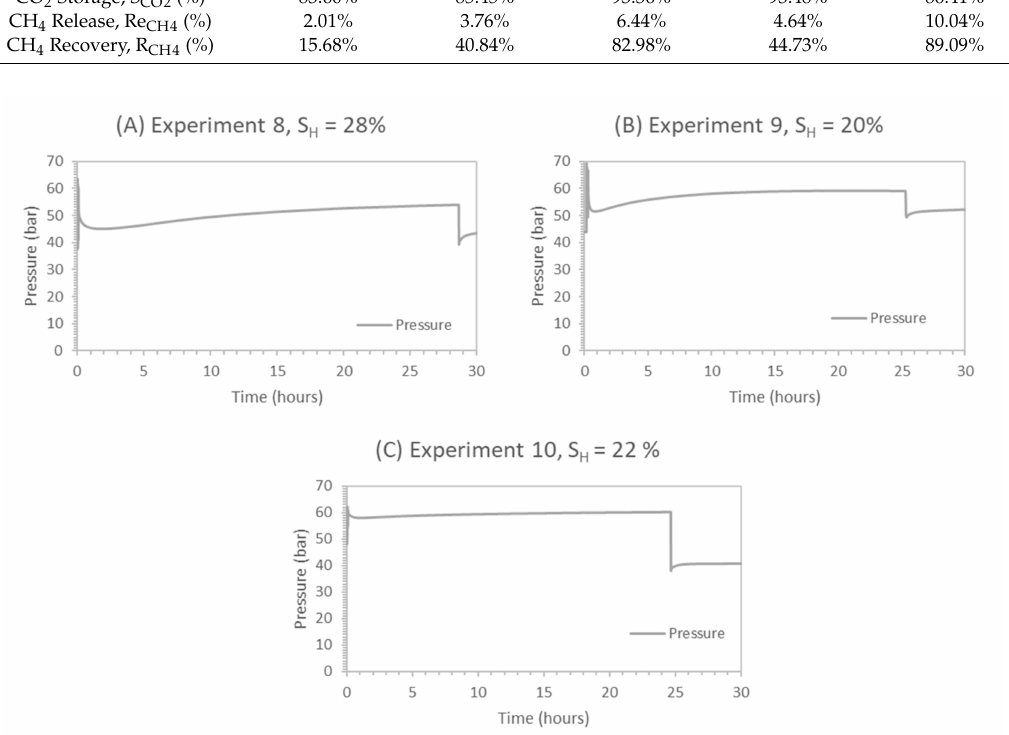
Figure 14. Pressure profiles for CH 4 -CO 2 replacement process at 1 ◦ C and for 24-h soaking period. Experiments 8–10 at di ff erent S wi and in the presence 5 wt% MeOH in water. Sudden drop in pressure at the end of 24 h corresponds to gas collection for GC analysis followed by controlled depressurization. ( A ) Pressure profile after CO 2 injection and during the soaking period in experiment 8; ( B ) Pressure profile after CO 2 injection and during the soaking period in experiment 9; ( C ) Pressure profile after CO 2 injection and during the soaking period in experiment